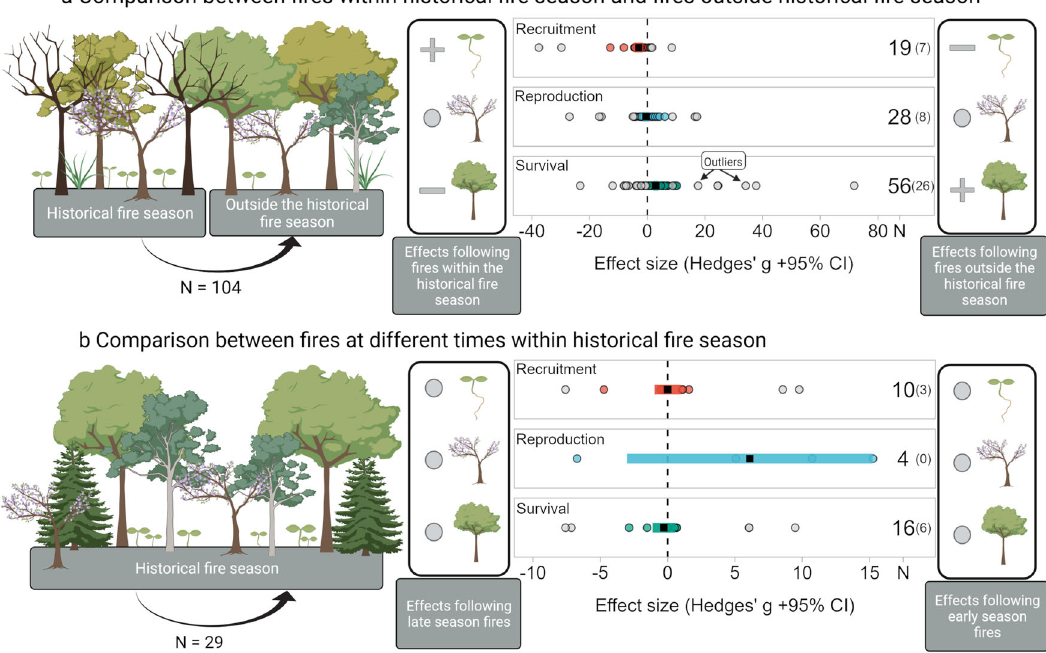
Fig. 1 Success of post- fi re plant recovery strategies varies with shifting fi re seasonality. Conceptual design and pooled results of meta-analysis for paired comparisons a Comparison between fi res occurring within the historical fi re season and fi res occurring outside the fi re season. b Comparison between fi res occurring early and late season fi re in the historical fi re season. Modelled mean effects and 95% con fi dence intervals around the mean presented, coloured points represent studies within 95% CI of pooled effect size estimate and non-coloured points have been identi fi ed as outliers and excluded from analysis. Negative Hedges ’ g -values represent increased effects following fi res in the historical fi re seasons (in a ) or late season fi res (in b ) relative to fi res outside historical fi re seasons early season fi res, respectively. Positive Hedges ’ g -values represent increased effects following fi res outside historical fi re seasons (in a ) or early season fi res (in b ) relative to fi res in the historical fi re seasons late season fi res, respectively. N represents the number of paired comparisons (i.e., sample size) within each topic group, numbers within parenthesis adjacent to N numbers indicate number of outliers that were identi fi ed within each analysis. Conceptual diagrams created with